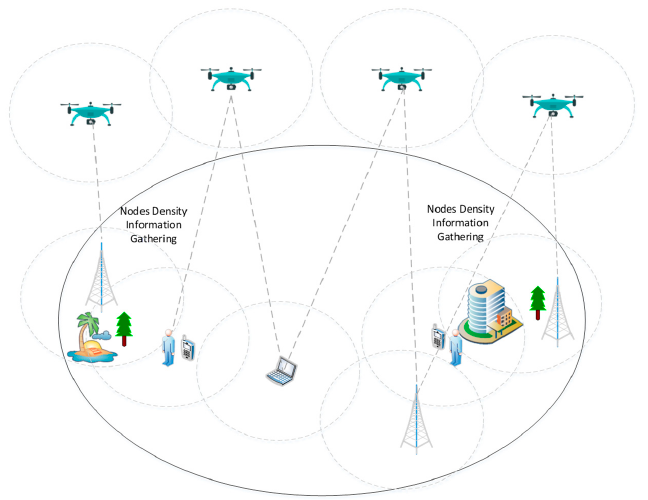
Figure 4. Communication Range of all Components in the Network.